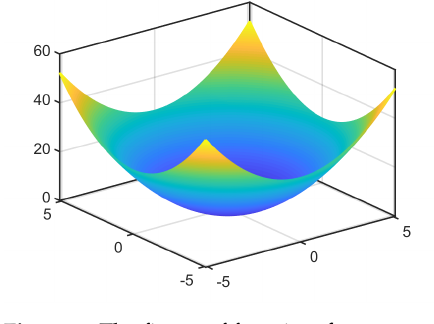
Figure 3. The figure of function f 1 .